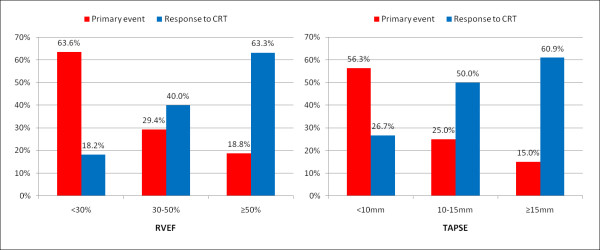
Frequency of primary events and response to CRT for different ranges of RVEF and TAPSE.